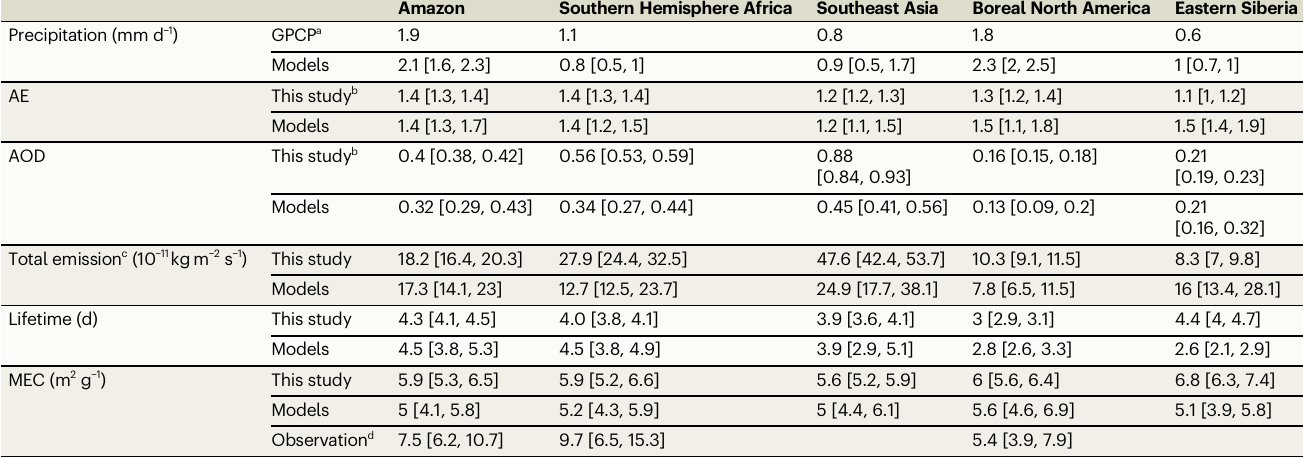
Table 1 | The constrained results from the present study compared with AeroCom models and observations Amazon Southern Hemisphere Africa Southeast Asia Boreal North America Eastern